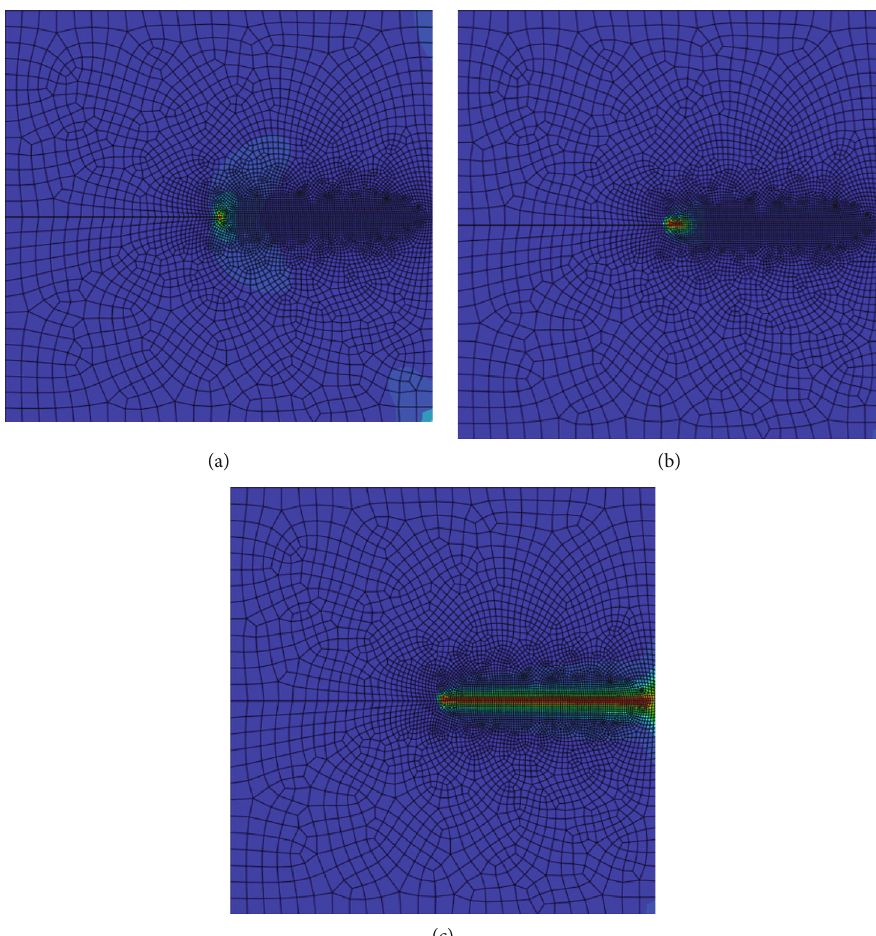
Figure 5: The propagation of crack when l = 0 : 0075mm . (a) Crack initiation stage. (b) Crack development stage. (c) Crack penetration